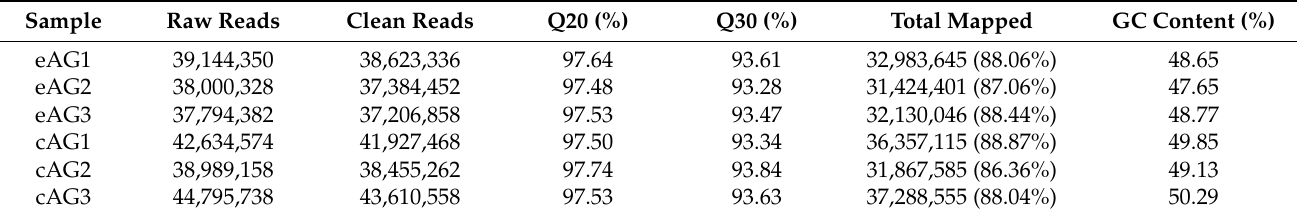
Table 1. Summary of the sequencing and mapping output of all samples.